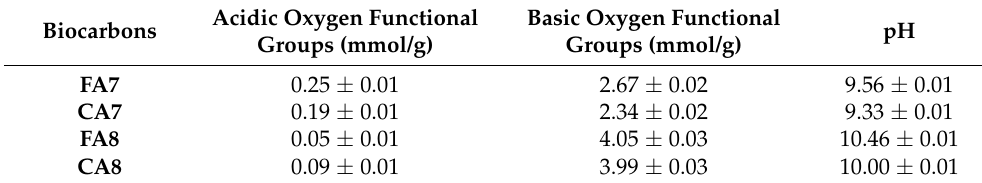
Table 3. Acid-base properties of the biocarbons obtained.